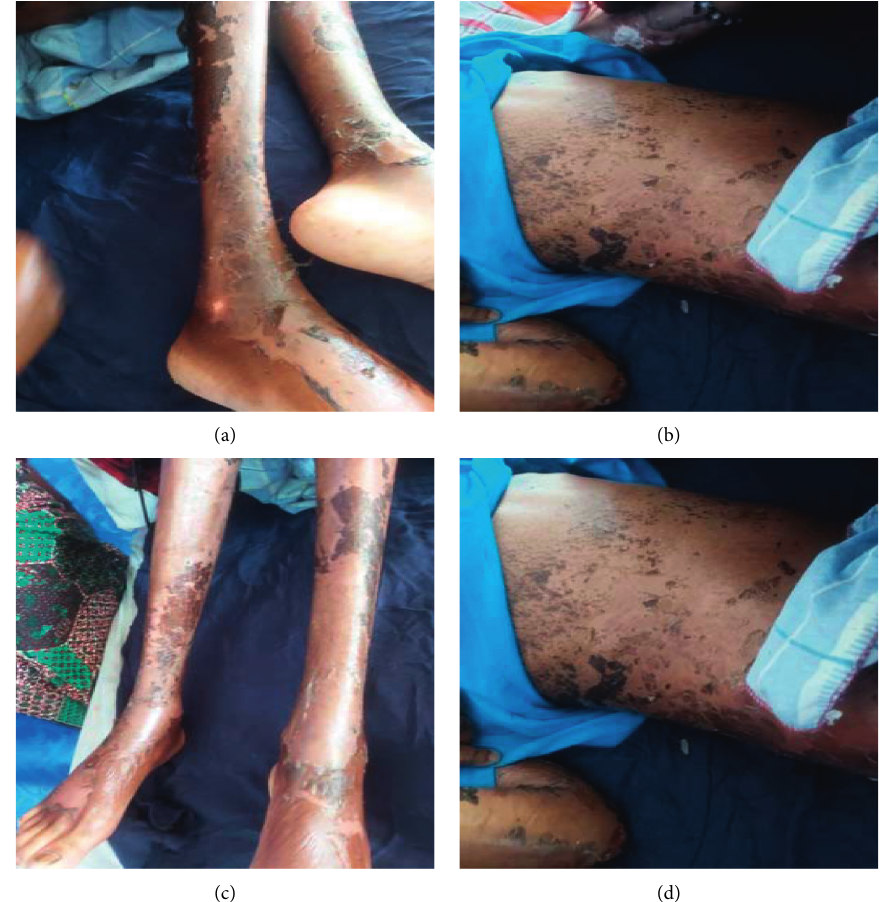
Figure 4: Skin changes after zinc replacement with evident re-epithelialization after about a week of zinc